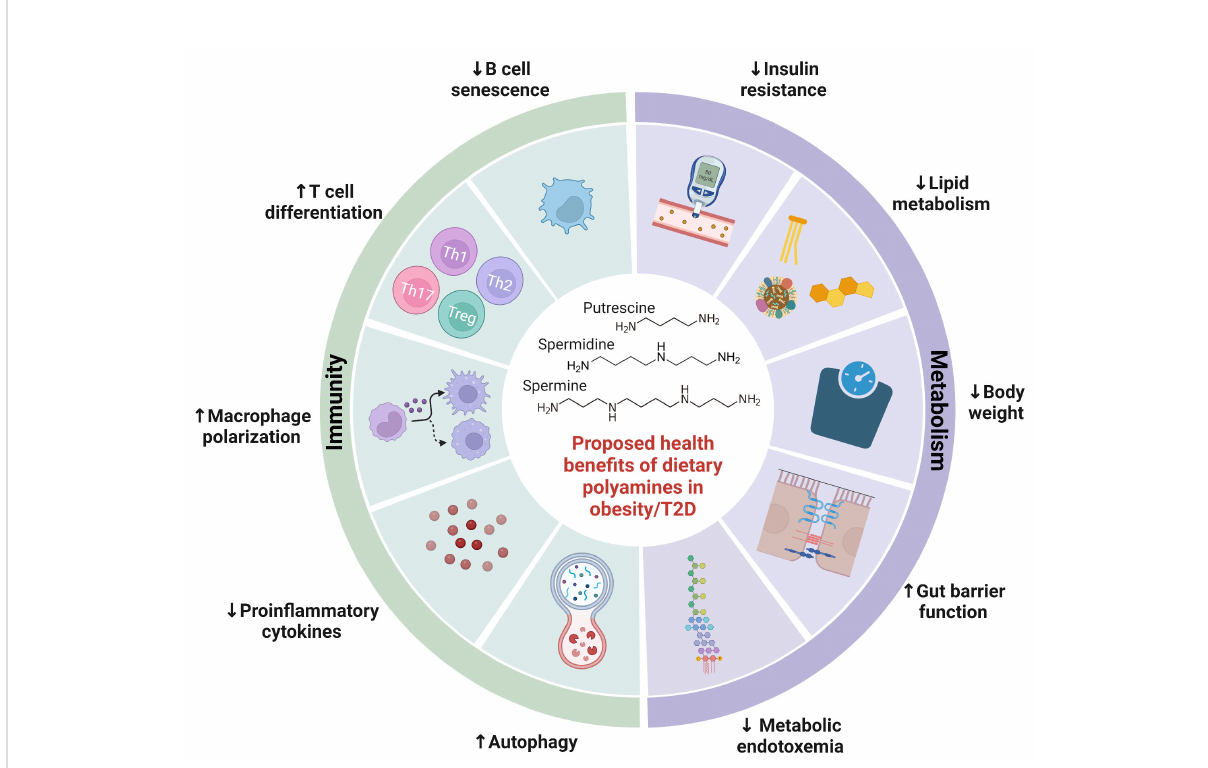
FIGURE 2 Proposed health bene fi ts of dietary polyamines in obesity-related diseases. Polyamines are essential to human health, with their abundance altered by obesity-related diseases. This fi gure highlights a summary of potential bene fi ts of polyamines on obesity-related diseases including metabolic syndrome and type 2 diabetes. Polyamines ameliorate metabolic syndrome by reducing weight gain, insulin resistance, lipid metabolism, gut barrier function, and metabolic endotoxemia. Polyamines also regulate both innate and adaptive immunity including proin fl ammatory cytokine production, autophagy, macrophage polarization, T cell differentiation, and B cell senescence. Further investigation is needed to elucidate polyamine-mediated health bene fi ts in obesity-related